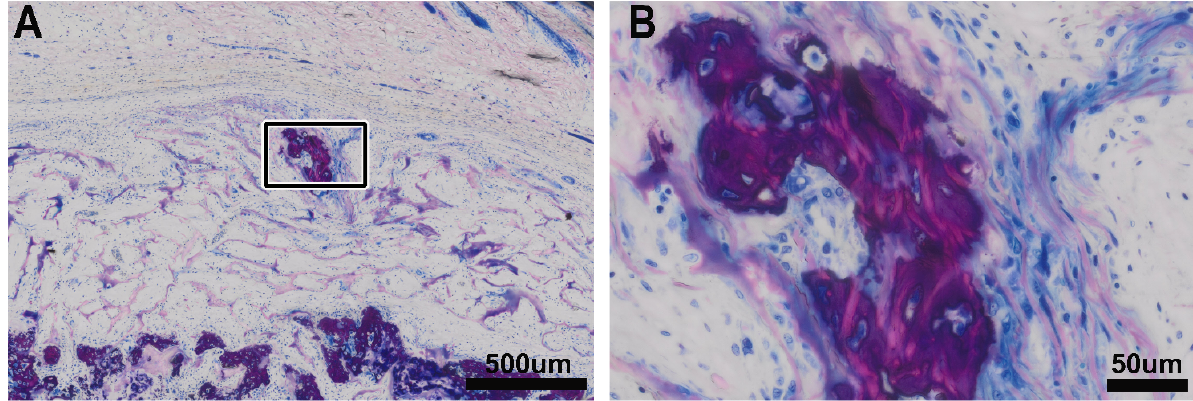
Figure 3. Mineralized VSCM. We also observed areas where the pink collagen bundles of VSCM were embedded in the dark purple newly formed mineralized matrix ( A ), again showing the morphological features of hypertrophic chondrocytes with the large lacunae and independent of an osteoid seam that indicates the functional activity of osteoblasts. ( B ) These mineralized islands can be next to the outer surface of the VSCM indicated by the paralleled and elongated fibroblastic cells that are independent and separated from the main front of mineralized tissue formation.